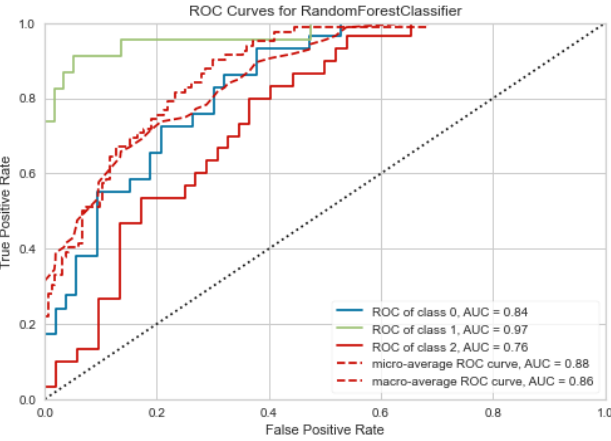
Fig. 4. ROC curve for RF classifier.